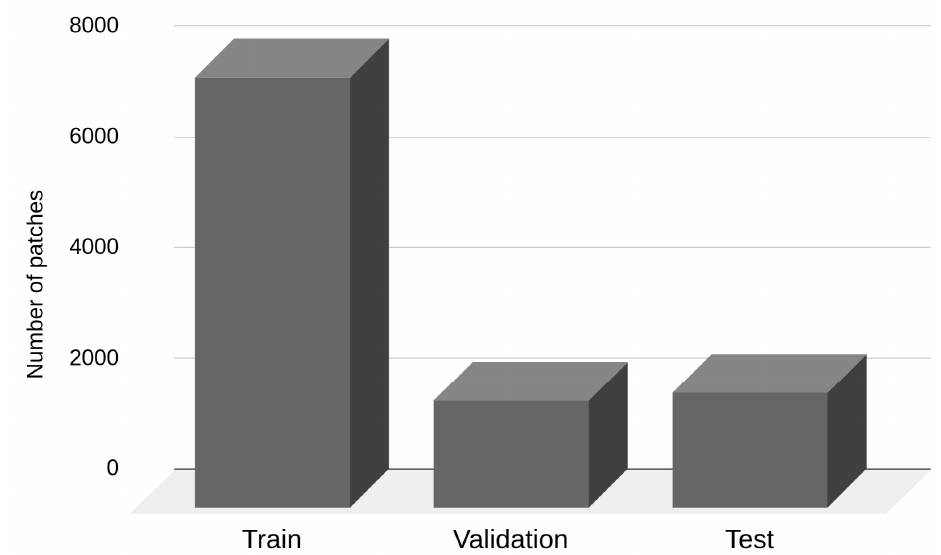
Figure 8. Histogram showing the distribution of training, validation and test set.